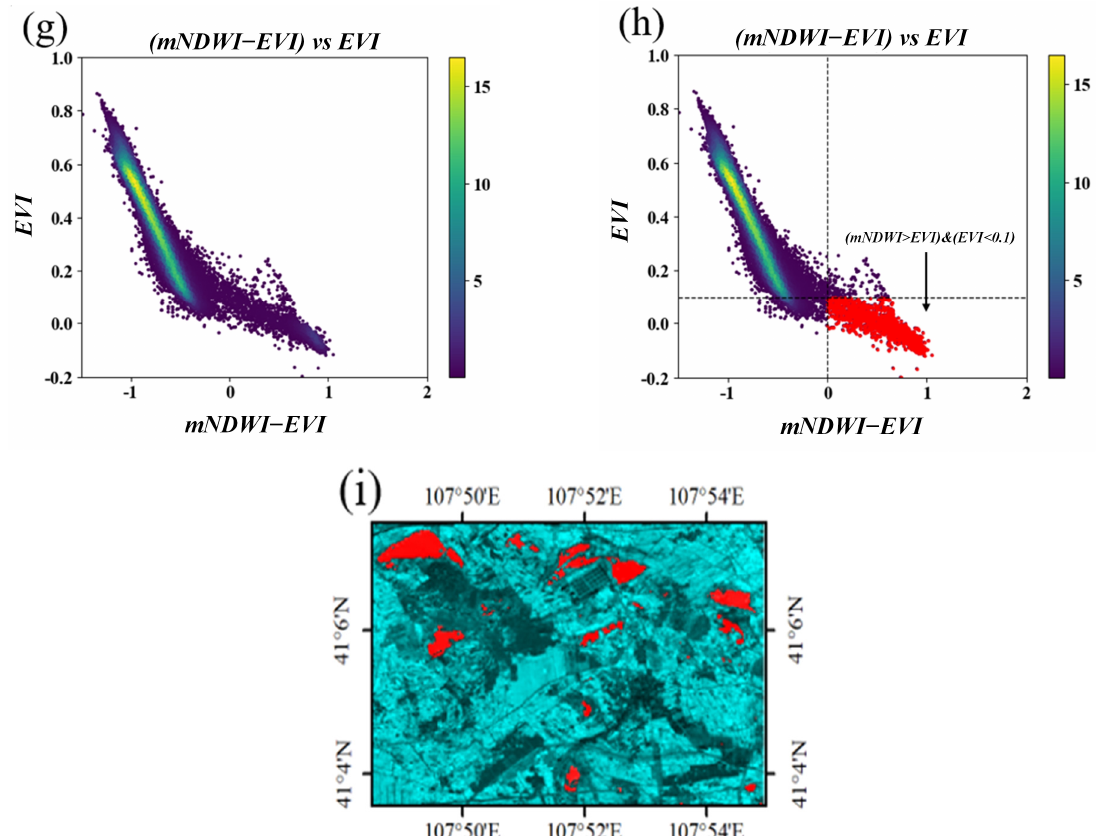
Figure 4. Distribution of the water body and non-water body: ( a ) Landsat Operational Land Imager (OLI) image (false color composite); ( b ) in the image, blue is the water body and white is the non-water body; ( c ) spatial distribution of the Enhanced Vegetation Index ( EVI ) value; ( d ) pixels scatter diagram between (modfied Normalized Di ff erence Water Index ( mNDWI ) > Normalized Di ff erence Vegetation Index ( NDVI )) and EVI ; ( e ) pixels that satisfy the conditions of (( mNDWI > NDVI ) vs. ( EVI < 0.1)) are water bodies, marked with red scattered points; ( f ) the red part of the image corresponds to the red scatter in the (e) diagram, indicating the water body; ( g ) pixels scatter diagram between ( mNDWI > EVI ) and EVI; ( h ) pixels that satisfy the conditions of (( mNDWI > EVI) vs. ( EVI < 0.1)) are water bodies, marked with red scattered points; ( i ) the red part of the image corresponds to the red scatter in the ( h ) diagram, indicating the water body.